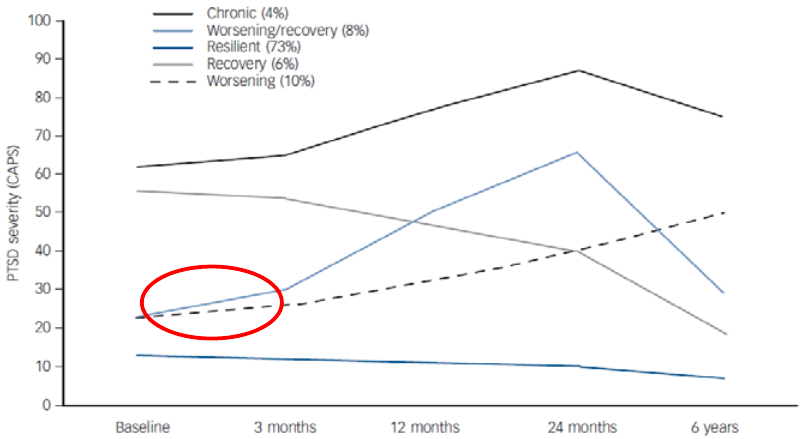
Figure 1. Posttraumatic stress disorder (PTSD) symptom trajectories over time. From Bryant et al. [37]. The red circle indicates the two trajectories of PTSD symptoms that may represent adjustment disorder trajectories.